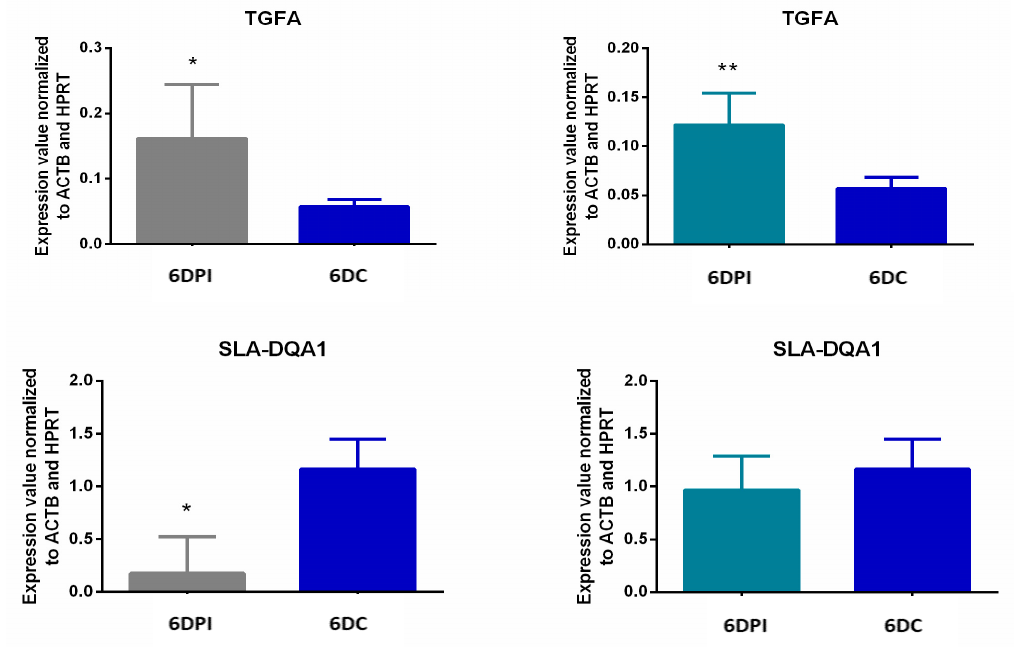
Figure 5. Validation of microarray results using qPCR. Expression of CCR3 ( chemokine ( C-C motif ) receptor 3 ), CXCL11 ( chemokine ( C-X-C motif ) ligand 11 ), TGFA ( transforming growth factor, α ), LGALS1 ( galectin 1 ), IL-18 ( interleukin 18 ), LY96 ( lymphocyte antigen 96 ), PDCD10 ( programmed cell death 10 ), SLA-DQA1 ( MHC class II histocompatibility antigen SLA-DQA ), S100A8 ( S100 calcium binding protein A8 ), and S100A12 ( S100 calcium binding protein A12 ) in the Day 6 of pregnant or SP infused animals as compared to Day 6 of cycling control animals. Expression values were normalized to expression of ACTB (Actin, β ) and HPRT (Hypoxanthine phosphoribosyltransferase1) . Data are presented as mean ± standard error. * p ≤ 0.05, ** p ≤ 0.01, *** p ≤ 0.001 by t -test. The fold change and p values are shown in Table